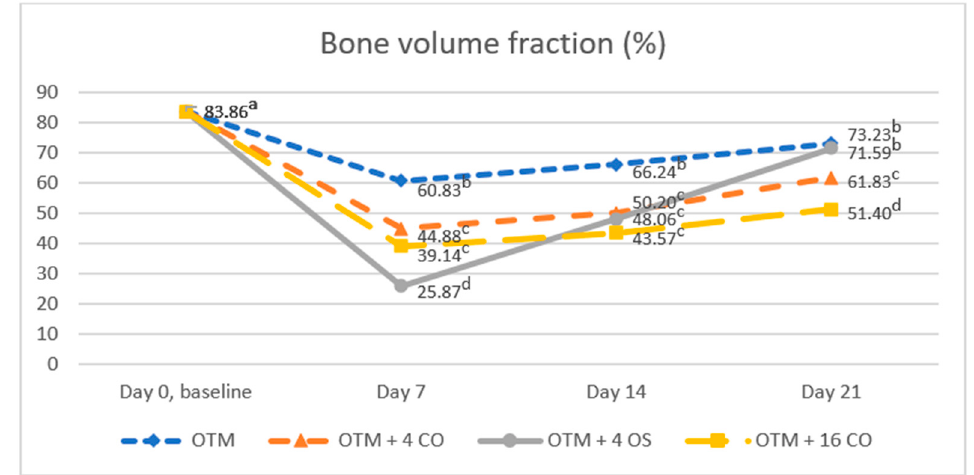
Figure 7. Comparison of the bone volume fraction. Different superscript letters (a, b, c, d) indicate statistically significant differences between groups ( p < 0.05).